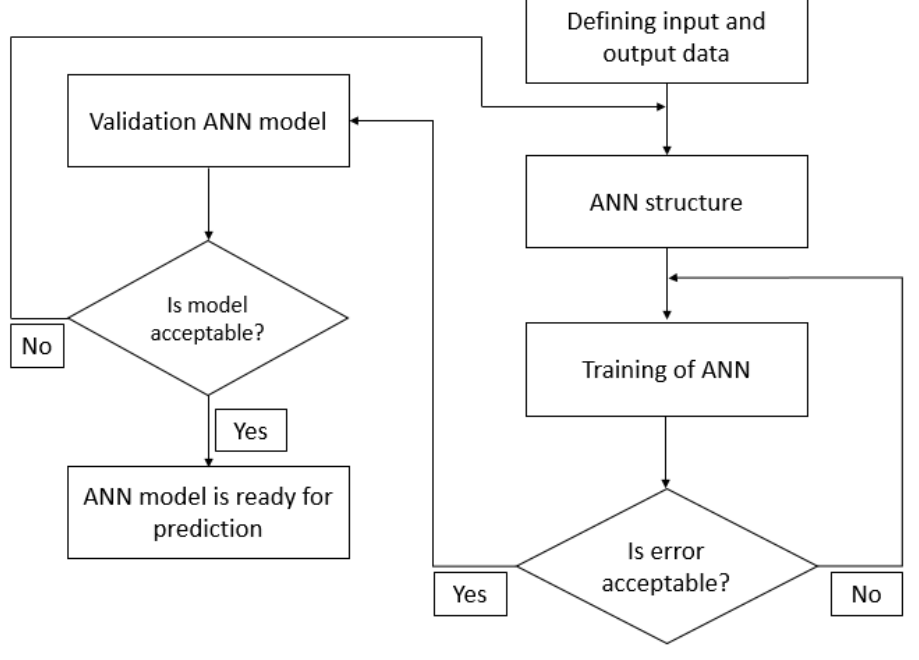
Figure 3. Prediction algorithm using ANN .